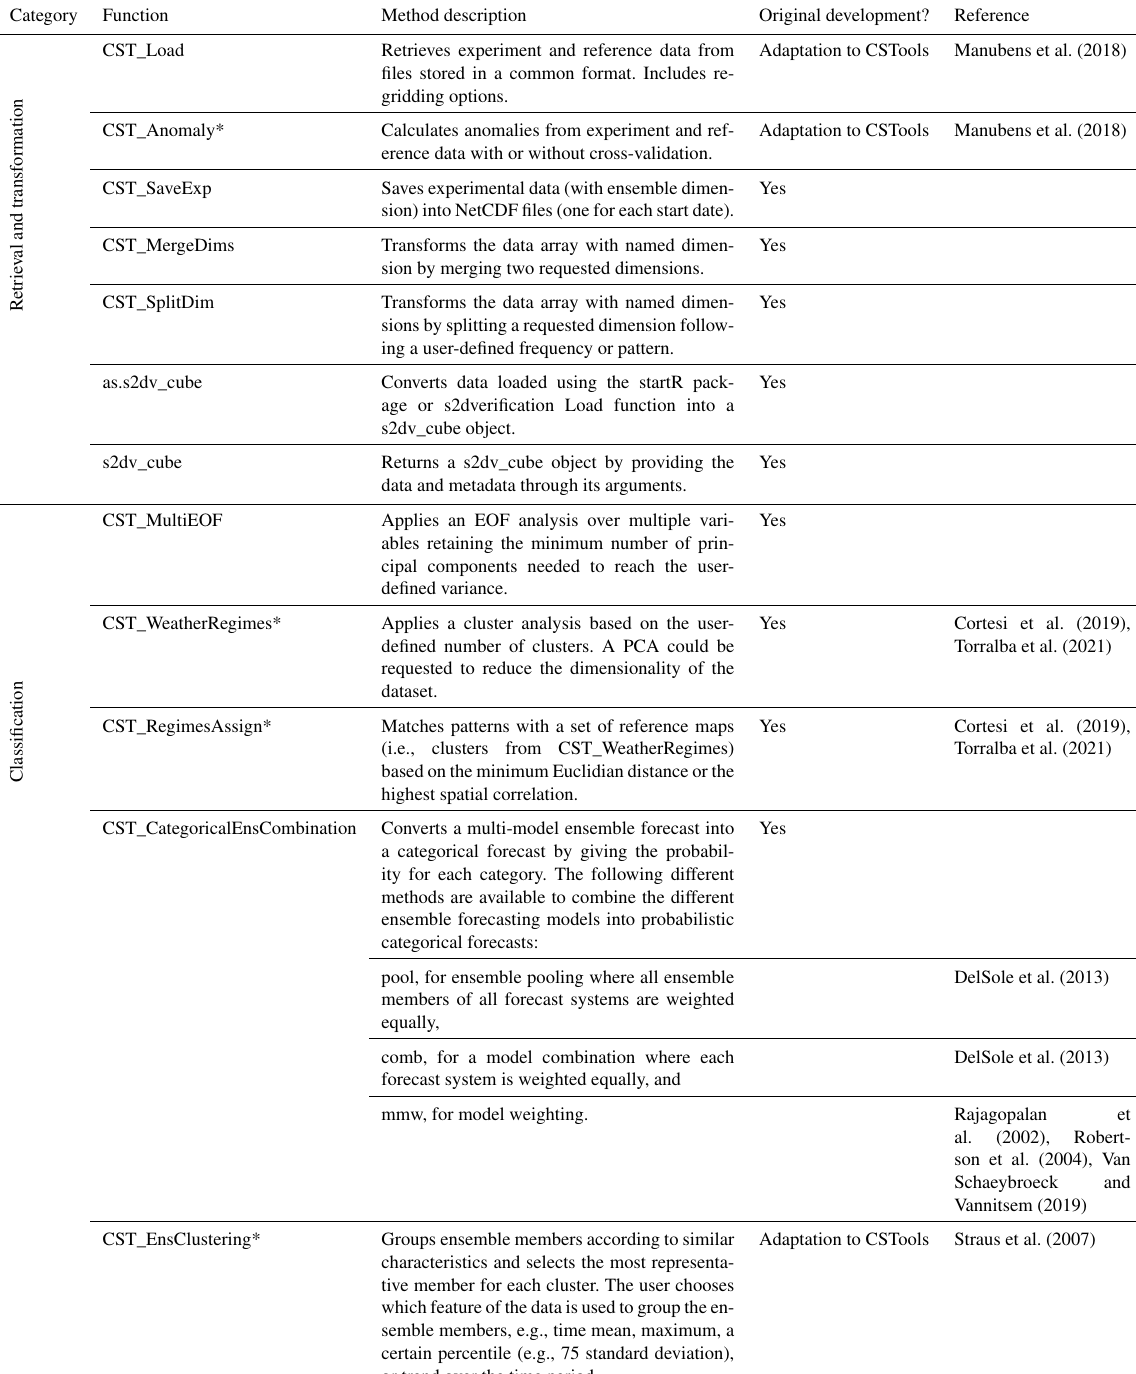
Table B1. Summary of the functions and methods by category, including a description and the origin of the first known code and the references. The prefix CST_ refers to functions working on a specific object class called s2dv_cube, while those without the prefix accept multi-dimensional arrays with named dimensions as input. Asterisks indicate functions that are used in vignettes. Note: PCA is a principal component